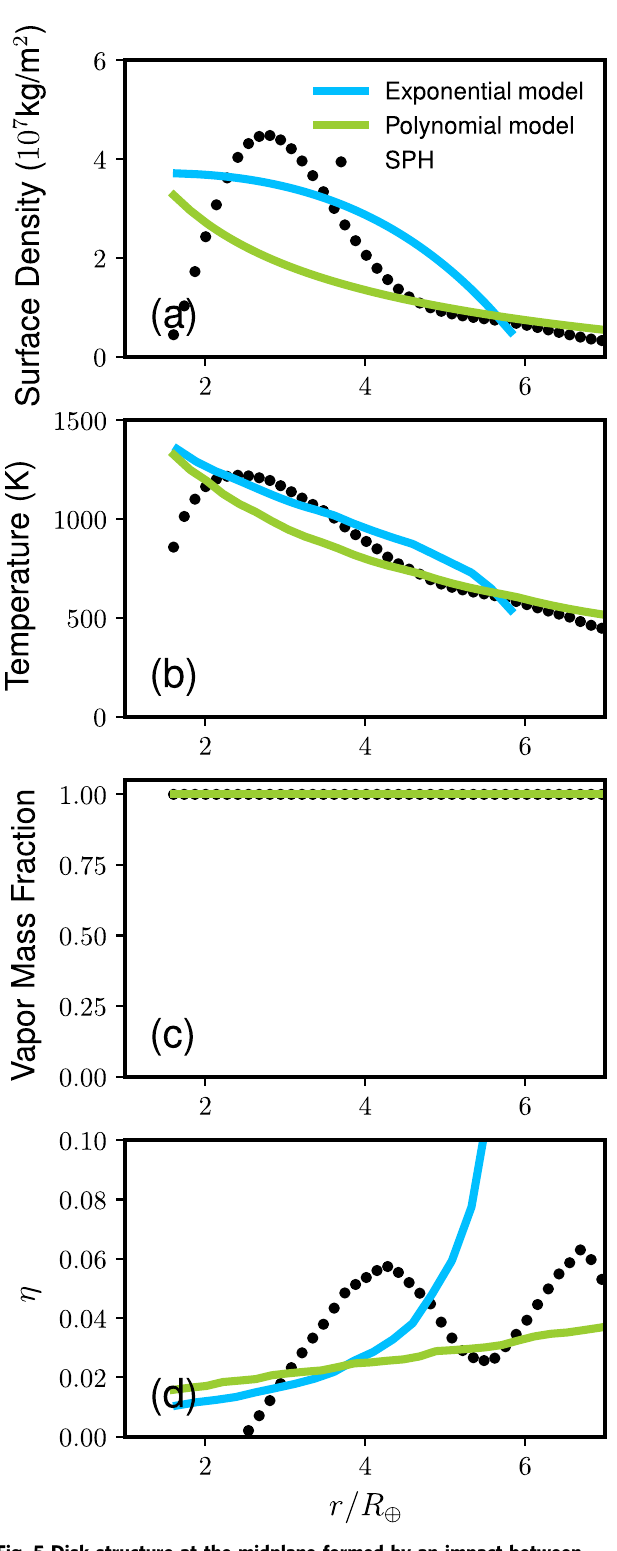
Fig. 5 Disk structure at the midplane formed by an impact between icy planets ( M T = 1 M ⊕ , γ = 0.13, θ = 48. 5 ∘ , v imp = v esc , Run ID20). The line descriptions are the same as those in Fig. 4. The panels show ( a ) the surface density, ( b ) temperature, ( c ) vapor mass fraction, and ( d ) pressure gradient parameter η as a function of r/ R ⊕ . The planetary radius is 1.42 R ⊕